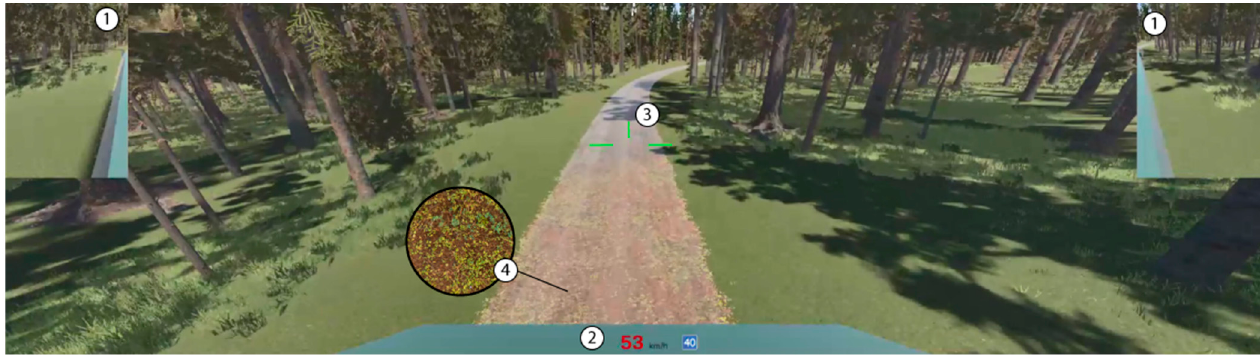
Figure 2. An image of the forest road with a slippery spot ahead: 1—two side cameras, 2—dashboard with current speed and recommended speed, 3—horizon line, 4—mud texture.